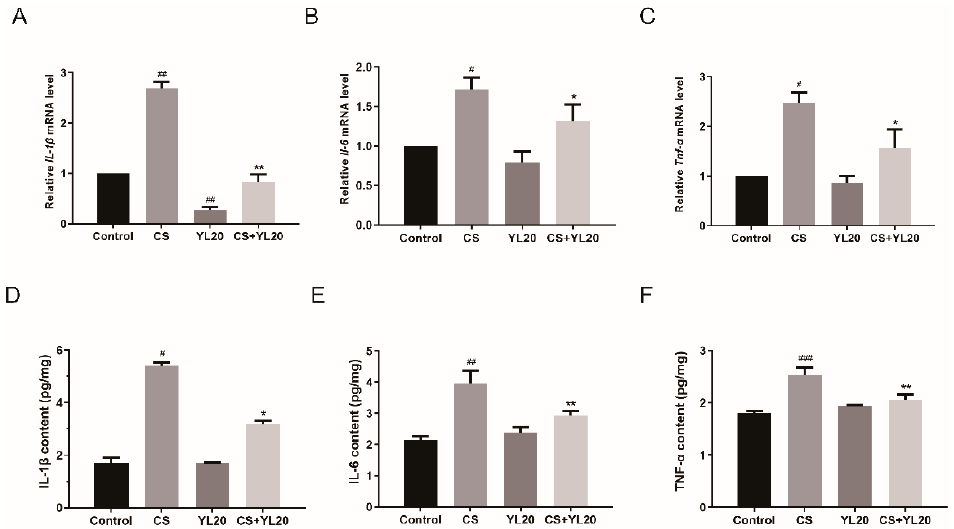
Figure 6. Effects of YL20 administration on C. sakazakii -induced inflammatory factors in the intesti- nal tract of newborn mice. ( A – C ) RT-PCR analysis of the mRNA levels of IL-1 β , IL-6 and TNF- α in small intestinal tissues from C. sakazakii -infected mice with or without YL20 administration. ( D – F ) ELISA analysis of the release of pro-inflammatory cytokines. # p < 0.05, ## p < 0.01, ### p < 0.001 vs. Control group; * p < 0.05, ** p < 0.01 vs. CS group; n = 3.